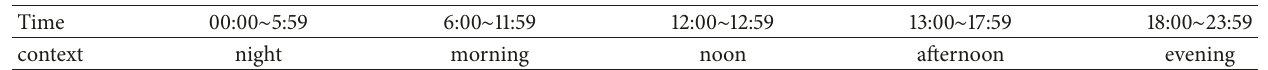
Table 2: The Division of Time (time).